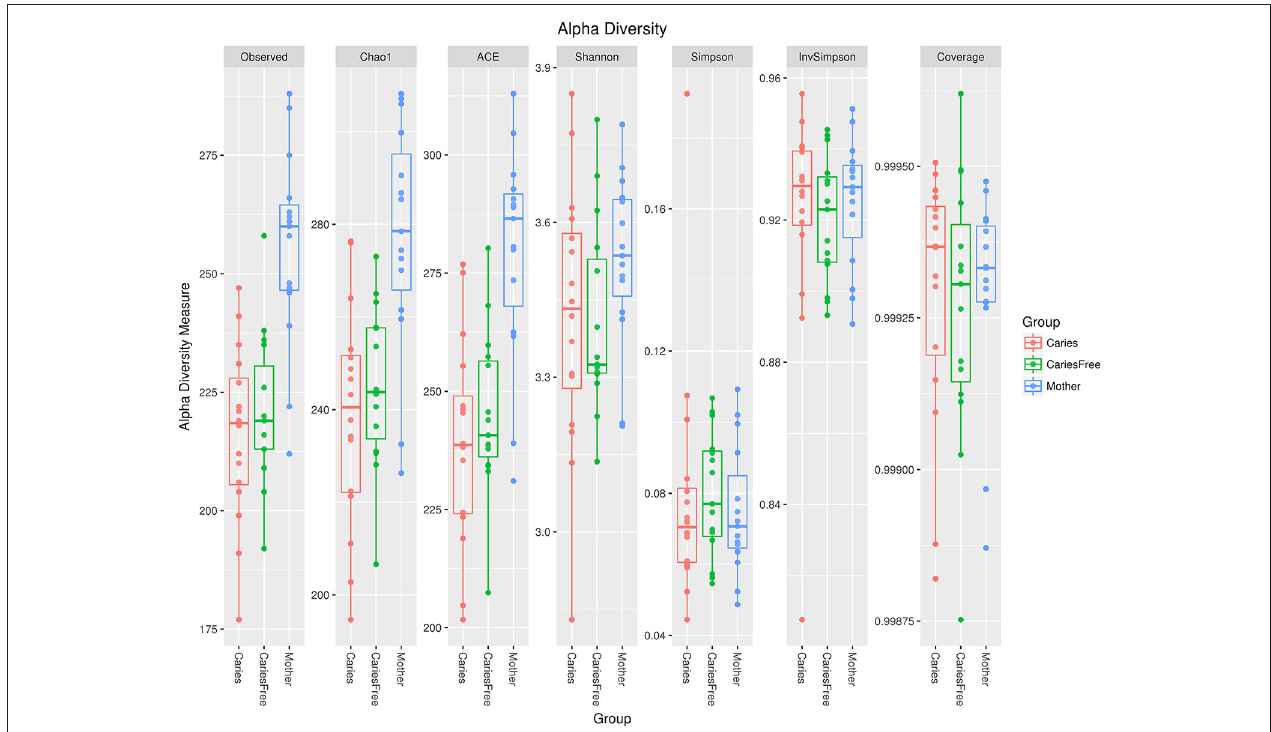
FIGURE 2 | Alpha diversity indices in three groups. There were significant differences in microbial richness between the mothers group and the caries ( P < 0.001) and caries-free ( P = 0.001) groups. The Shannon index in the mothers group was much higher than in the caries ( P = 0.003) and the caries-free ( P = 0.009)